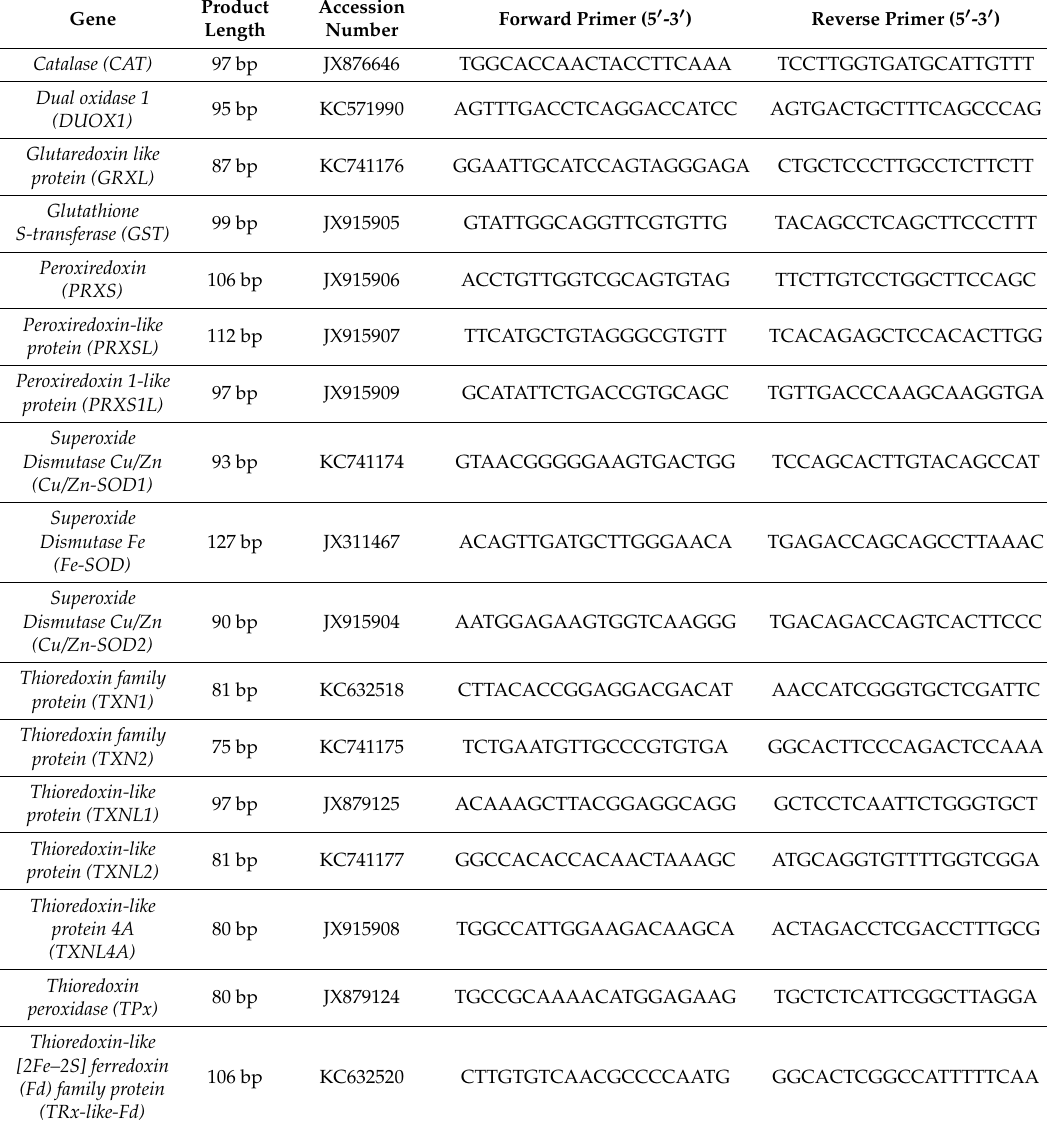
Table 4. Antioxidant genes used to study expression patterns of the whole body homogenates of winged imagoes, nymphs, soldiers and workers of C. formosanus Shiraki using quantitative real-time PCR (qRT-PCR). Product Accession Forward Primer (5 (cid:48) -3 (cid:48) ) Reverse Primer (5 (cid:48) -3 (cid:48) Gene Length Number